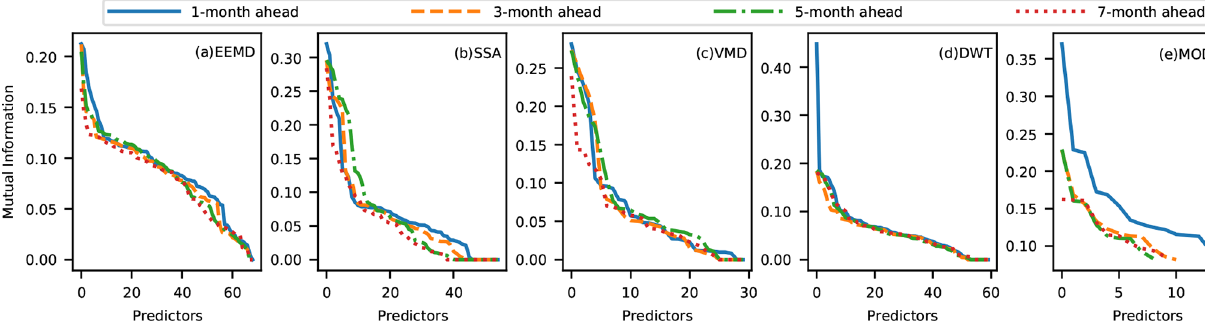
Figure 15. Mutual information between each predictor and the predicted target for the time-series data of the Huaxian station.